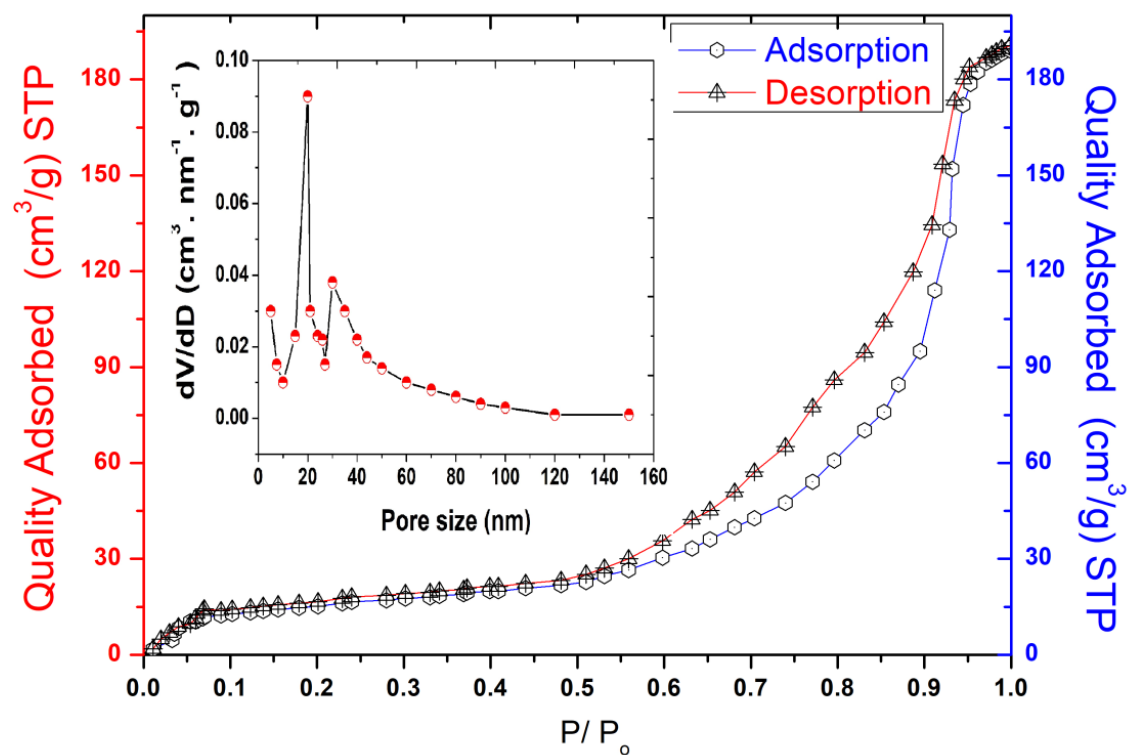
Figure 2. Size distribution analysis, BET adsorption, and desorption isotherms of Tamazert kaolin. The obtained results show that the BET curve fits the type IV isotherm according to the classification of the IPUAC, with an H3 hysteresis loop ranging between 0.50 and 0.90 relative pressure (P/P 0 ), indicating that this support has a typical mesoporous structure enhanced by the presence of meso and macroporous morphologies on its surface. The specific surface area of Tamazert kaolin was found to be 31.2 m 2 g − 1 , and the pore size distribution was reported to be in the range of 5–15 nm, as shown in Figure